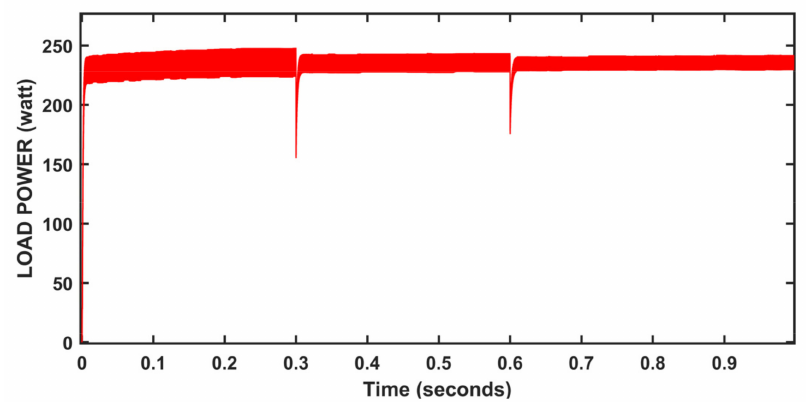
Figure 39. Performance at variable loads and constant irradiation and temperature.